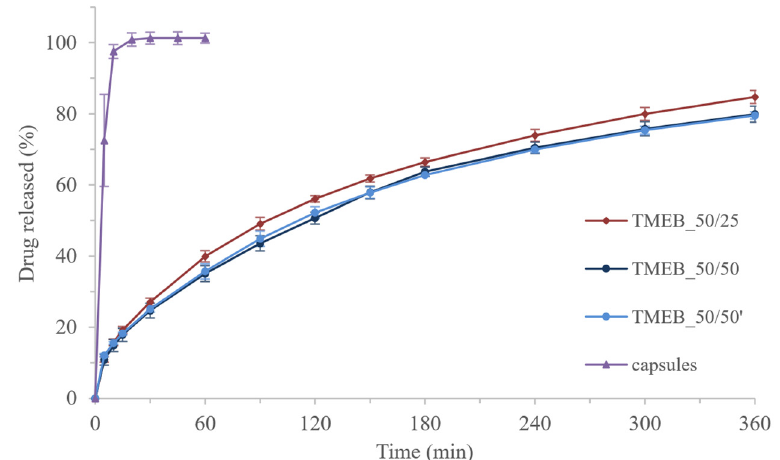
Figure 10. Dissolution profiles of MEB-loaded tablets.